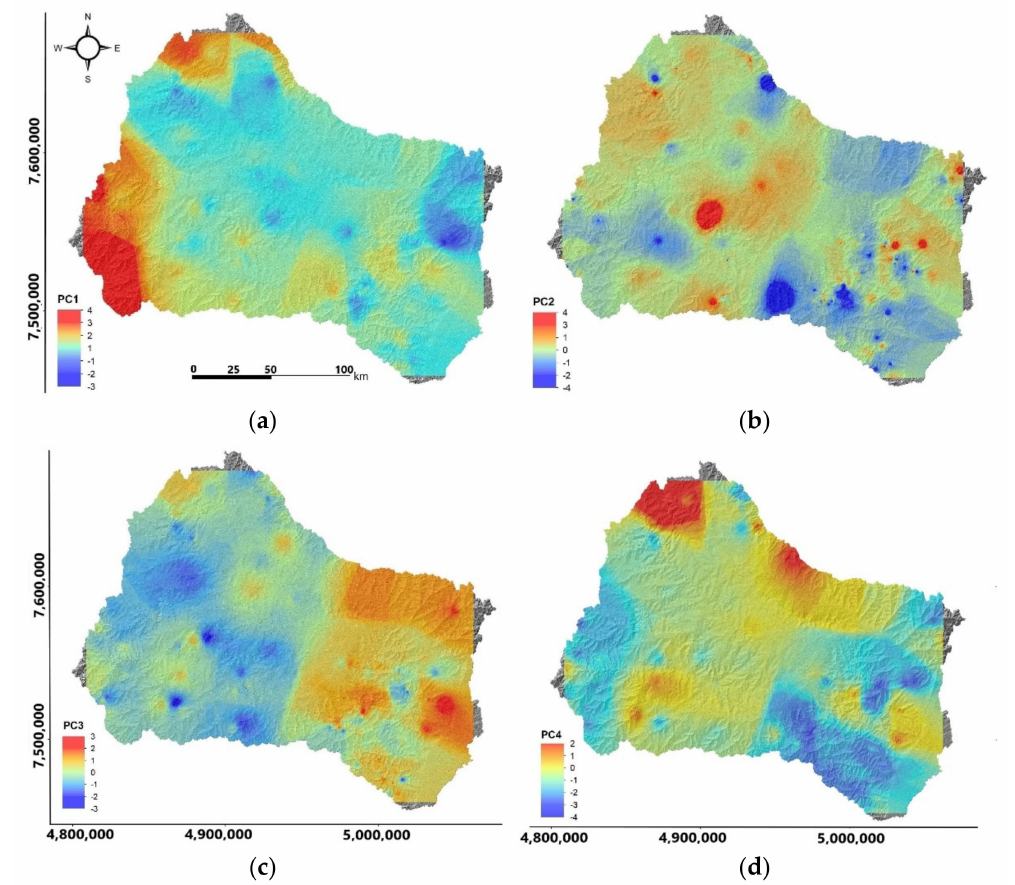
Figure 6. Distribution of the first four principal components ( a – d ), respectively) in the study area. Spatial references SIRGAS_2000_Brazil_Polyconic in